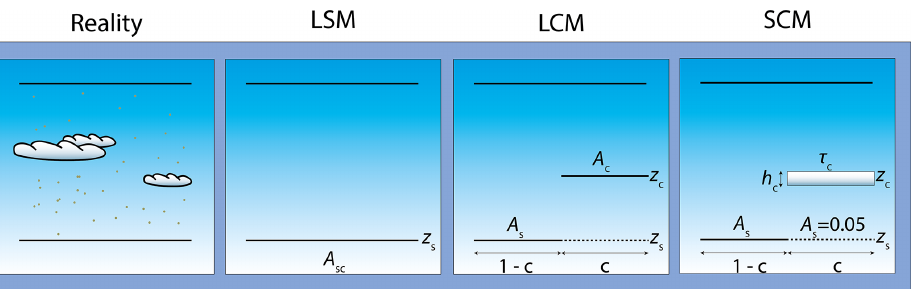
Figure 8. Schematic overview of the retrieval scene; z s is the surface height, A sc the scene albedo, c the effective cloud fraction (derived at 380nm), z c the cloud top height, and A c the cloud albedo. In the SCM, A c = 0 . 8, which is determined by a cloud layer thickness h c of 1km and a cloud optical thickness τ c of 28. The fit parameters for the LSM retrieval are A sc and the AAI; for the LCM and SCM retrievals, these are c and the